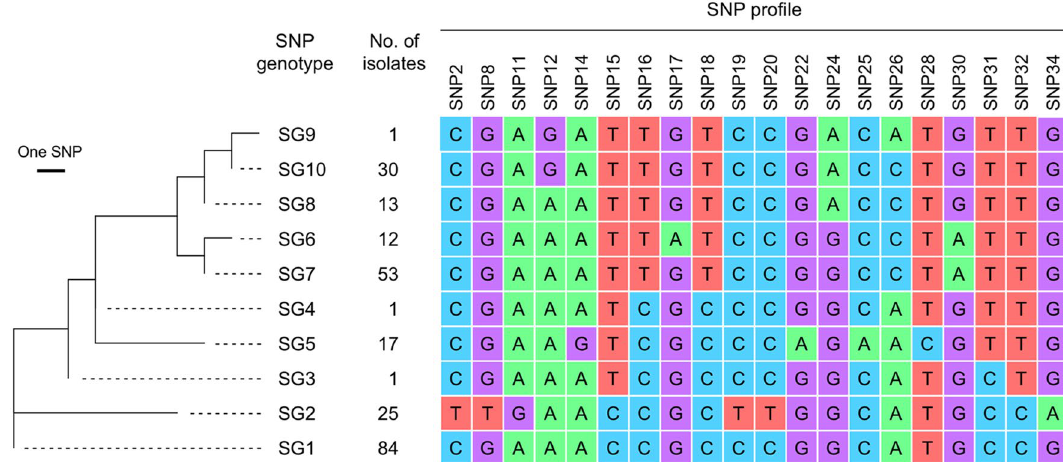
Figure 1. Maximum parsimony tree of Bordetella pertussis MT27 isolates based on 20-position SNP profile. A total of 237 isolates collected in Japan were analyzed by SNP genotyping and were divided into 10 SNP genotypes (SGs). The phylogenetic tree was constructed using MEGA7. The branch length is proportional to the number of SNP differences. The 20-position SNP profiles are shown on the